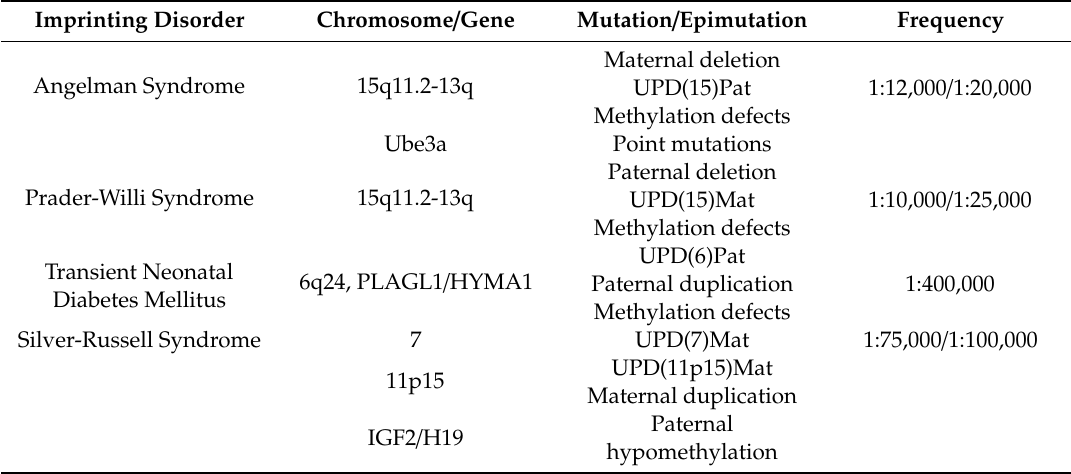
Table 1. An overview of the chromosomal regions and frequency of mutations / epimutations for four selected rare